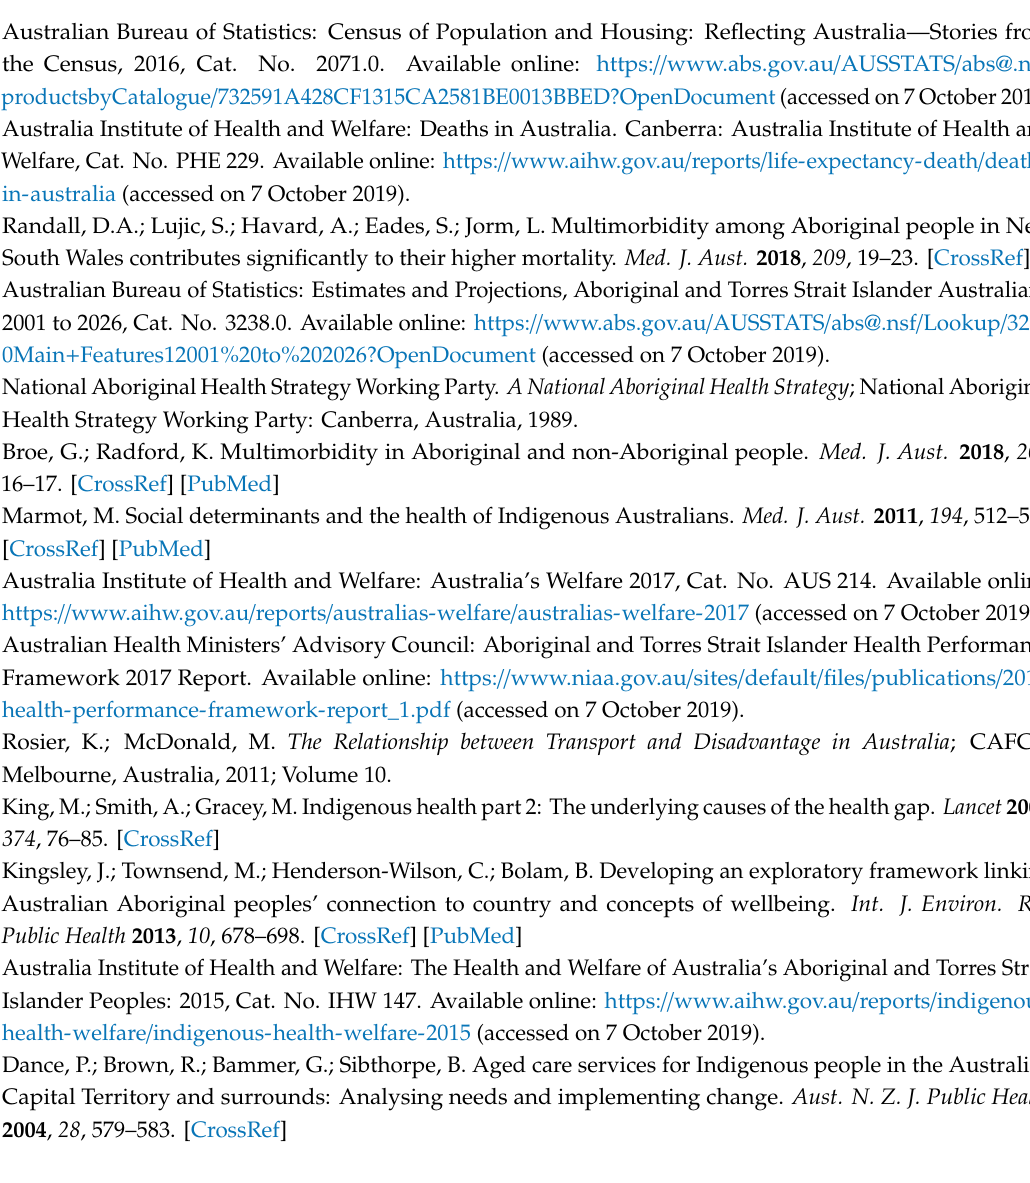
Supplementary Material Table S1: Semi-structured interview questions. Supplementary Material Table S2: Coding and